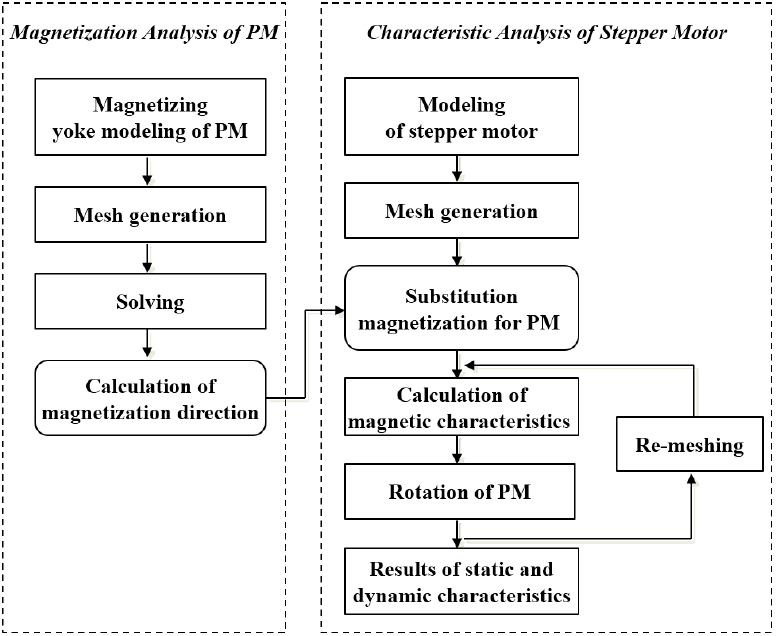
Figure 3. Flowchart of the magnetic characteristic calculation of the stepper